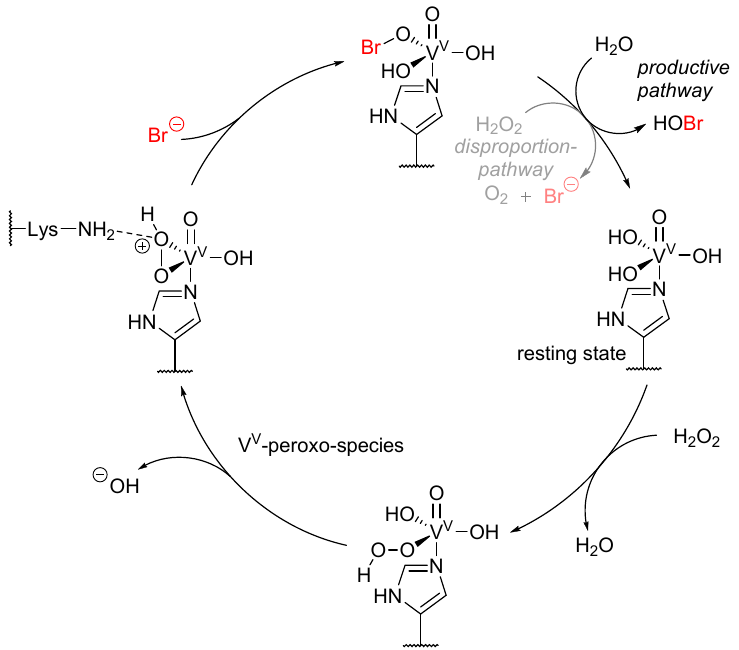
Figure 9. Proposed catalytic cycle of vanadium-dependent haloperoxidases. In its resting state (3 ‘o clock), vanadium contains four oxygen ligands, while the free coordination site is occupied by a catalytic histidine residue, resulting in a dative bond. In presence of hydrogen peroxide, a hydroxyl group is substituted by peroxide. Upon elimination of a hydroxide ion, a cycloperoxo-species is generated, which is stabilized by a catalytic lysine residue. This cyclic intermediate is opened by addition of a halide, in this case bromide, which can then be hydrolyzed by water, leading to the release of hypobromic acid, or in presence of another hydrogen peroxide molecule, be disproportioned to molecular oxygen and bromide. During catalysis, the vanadium does not alter its oxidation state (V) [55].